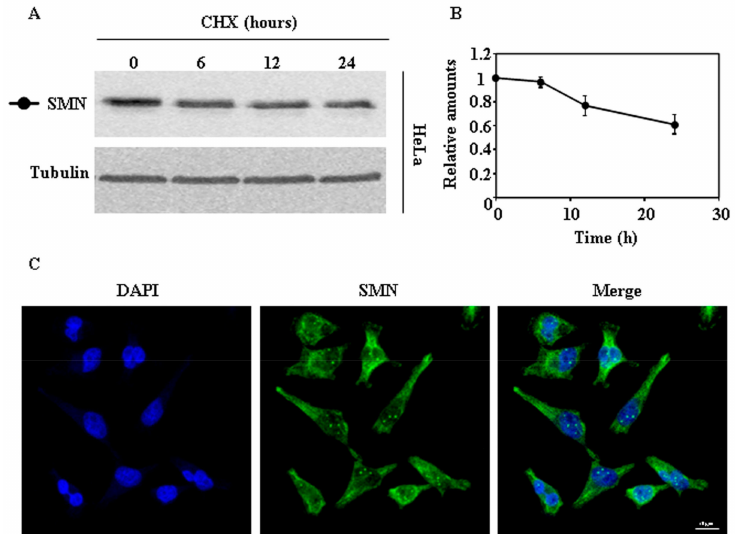
Figure 1. Degradation and subcellular localization of endogenous survival motor neuron (SMN) in HeLa cells. ( A ) HeLa cells were treated with cycloheximide (CHX) for the indicated times and cell extracts were analyzed by Western and immunoblot with anti-SMN antibodies. Anti-tubulin antibodies were used as total protein loading control. ( B ) Graph of quantification of the corresponding immunoblots. ( C ) Confocal fluorescence images of HeLa cells growing under basal conditions, stained with anti-SMN specific antibodies (green channel) and counterstained with DAPI (blue channel) for nuclei visualization. Bars = 10 µ m. Data are mean ± S.E.M. from at least three different